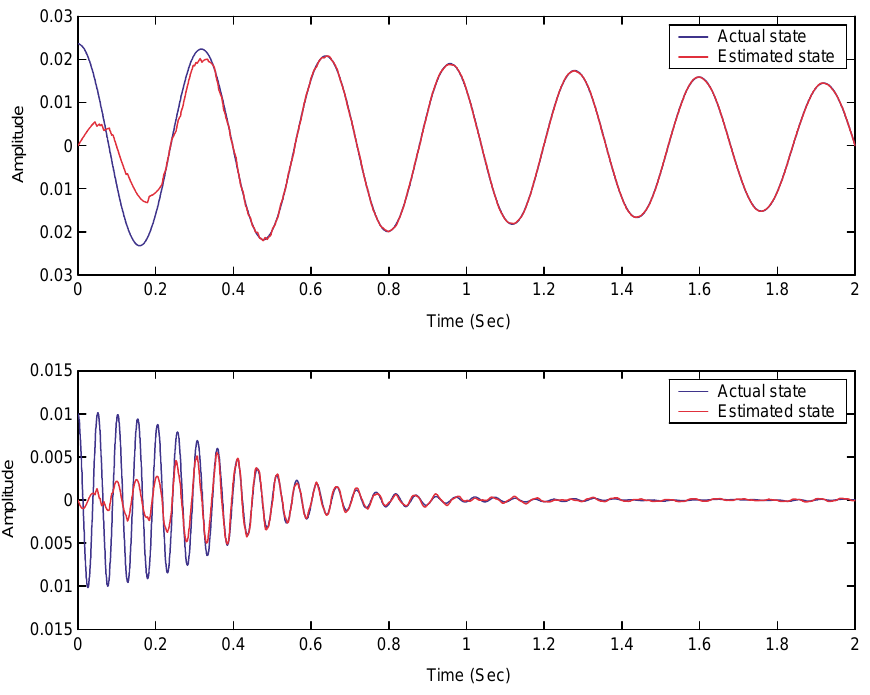
Fig. 7. State estimation performance of sliding mode observer with 180 Hz